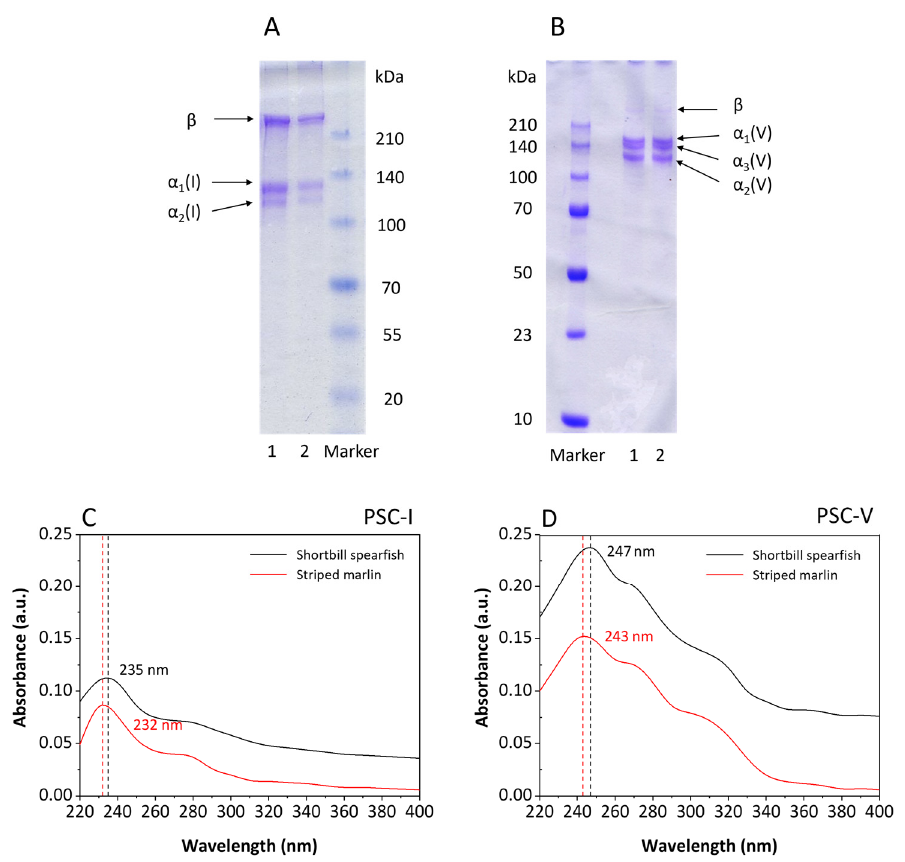
Figure 1. Characterization of PSC-I ( A , C ) and PSC-V ( B , D ) isolated from the skin of shortbill spearfish and striped marlin. M, 1, and 2 denote protein marker, and collagens from shortbill spearfish and striped marlin, respectively.